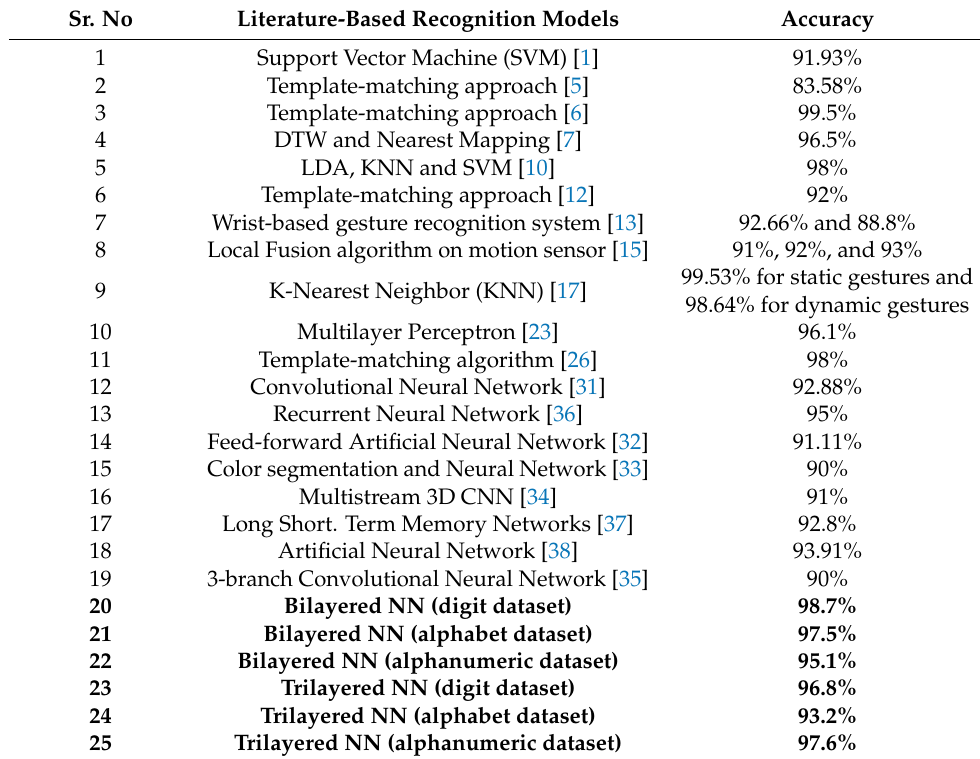
Table 2. Literature review-based accuracy analysis and